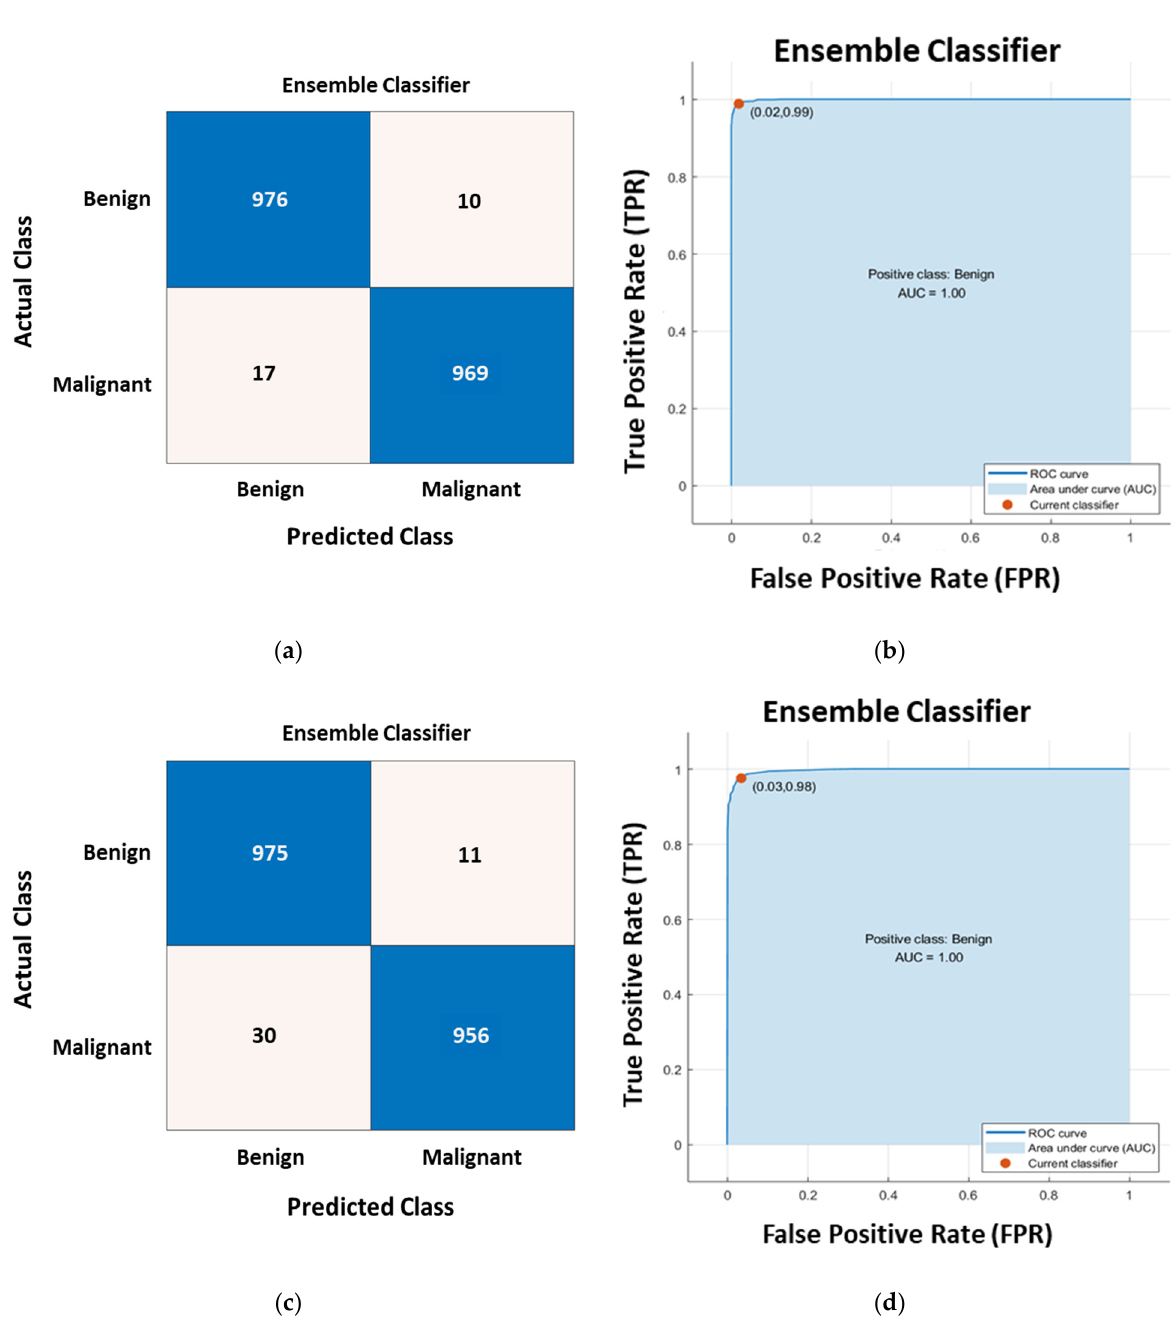
Figure 7. The confusion matrices and corresponding ROC curves of the classification results based on the proposed CAD system with deep extractor AlexNet and the LR-PCA. ( a ) The derived confusion matrix when the PCA is separately applied for each class; ( b ) The ROC curve when the PCA is separately applied for each class; ( c ) The confusion matrix when the PCA is applied across all classes; ( d ) The ROC curve when the PCA is applied across all